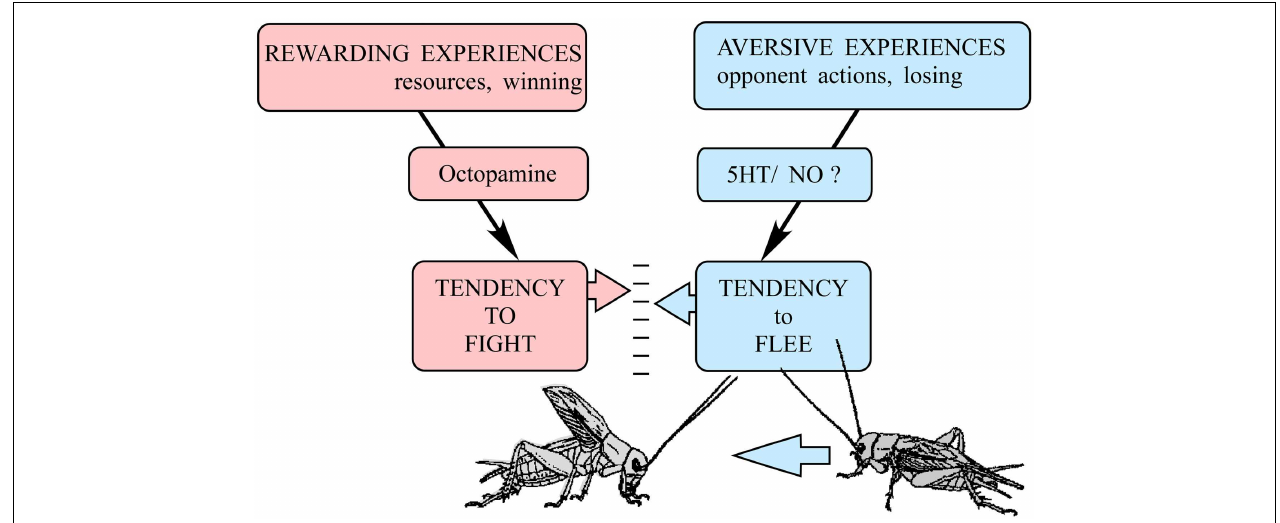
neuromodulators, which probably include serotonin (5HT), nitric oxide (NO), and selected peptides. In accord with the cumulative assessment hypothesis (Payne, 1998), a cricket will fight and persist as long as the perceived sum of rewarding experiences (motivation) exceeds the sum of accumulated aversive fighting experiences, but flee the moment the latter is greater. (adopted from Simpson and Stevenson,